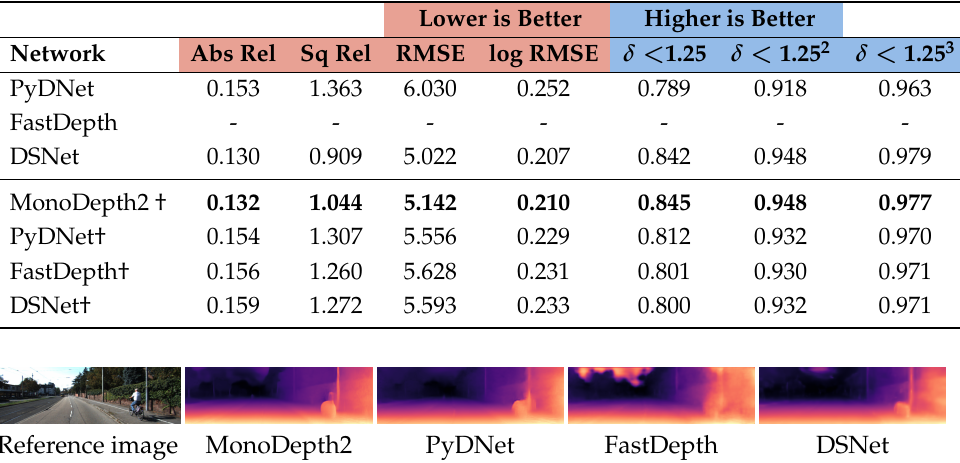
Figure 2. Qualitative results on KITTI. All the models have been trained equally using the framework of [26] on the Eigen split of